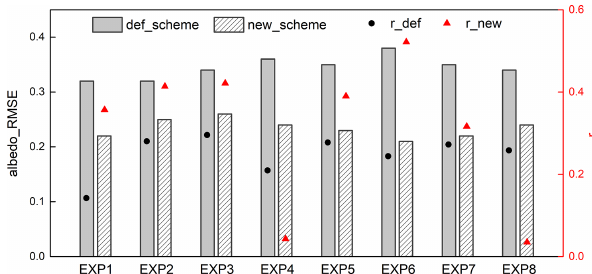
Figure 5. RMSE in column and correlation coefficient ( r ) in the scatterplot for albedo, comparing observations and model estimates. r_def and r_new mean r between the observations and WRF es- timates using the default albedo scheme and using the improved albedo scheme, respectively. Except for EXP4 and EXP8, the cor- relation coefficient is significant at the 0.01 significance level. For def_scheme and new_scheme, see Fig.